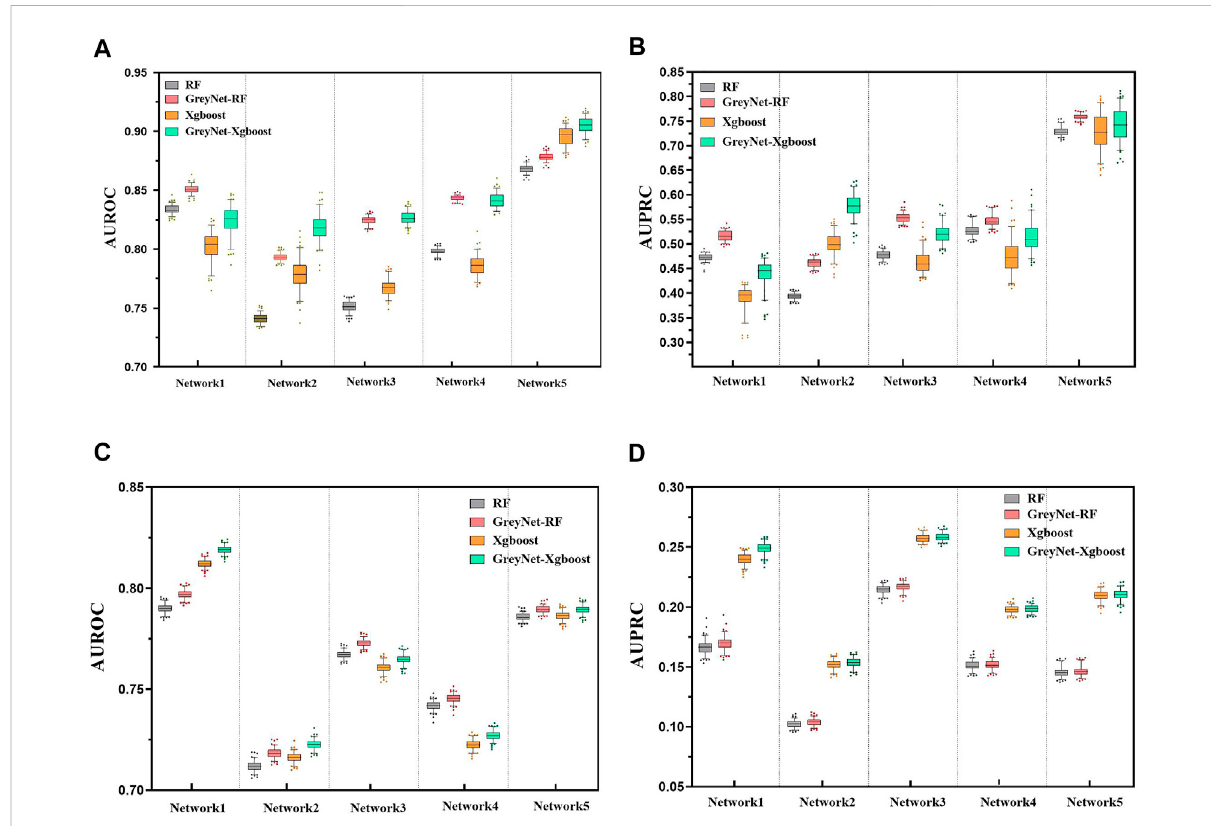
FIGURE 2 The comparison of RF, GreyNet-RF, Xgboost, and GreyNet-Xgboost on DREAM4 insilico datasets. (A) is the results of AUROC on DREAM4 size10 networks. (B) is the results of AUPRC on DREAM4 size10 networks. (C) is the results of AUROC on DREAM4 size100 networks. (D) is the results of AUPRC on DREAM4 size100